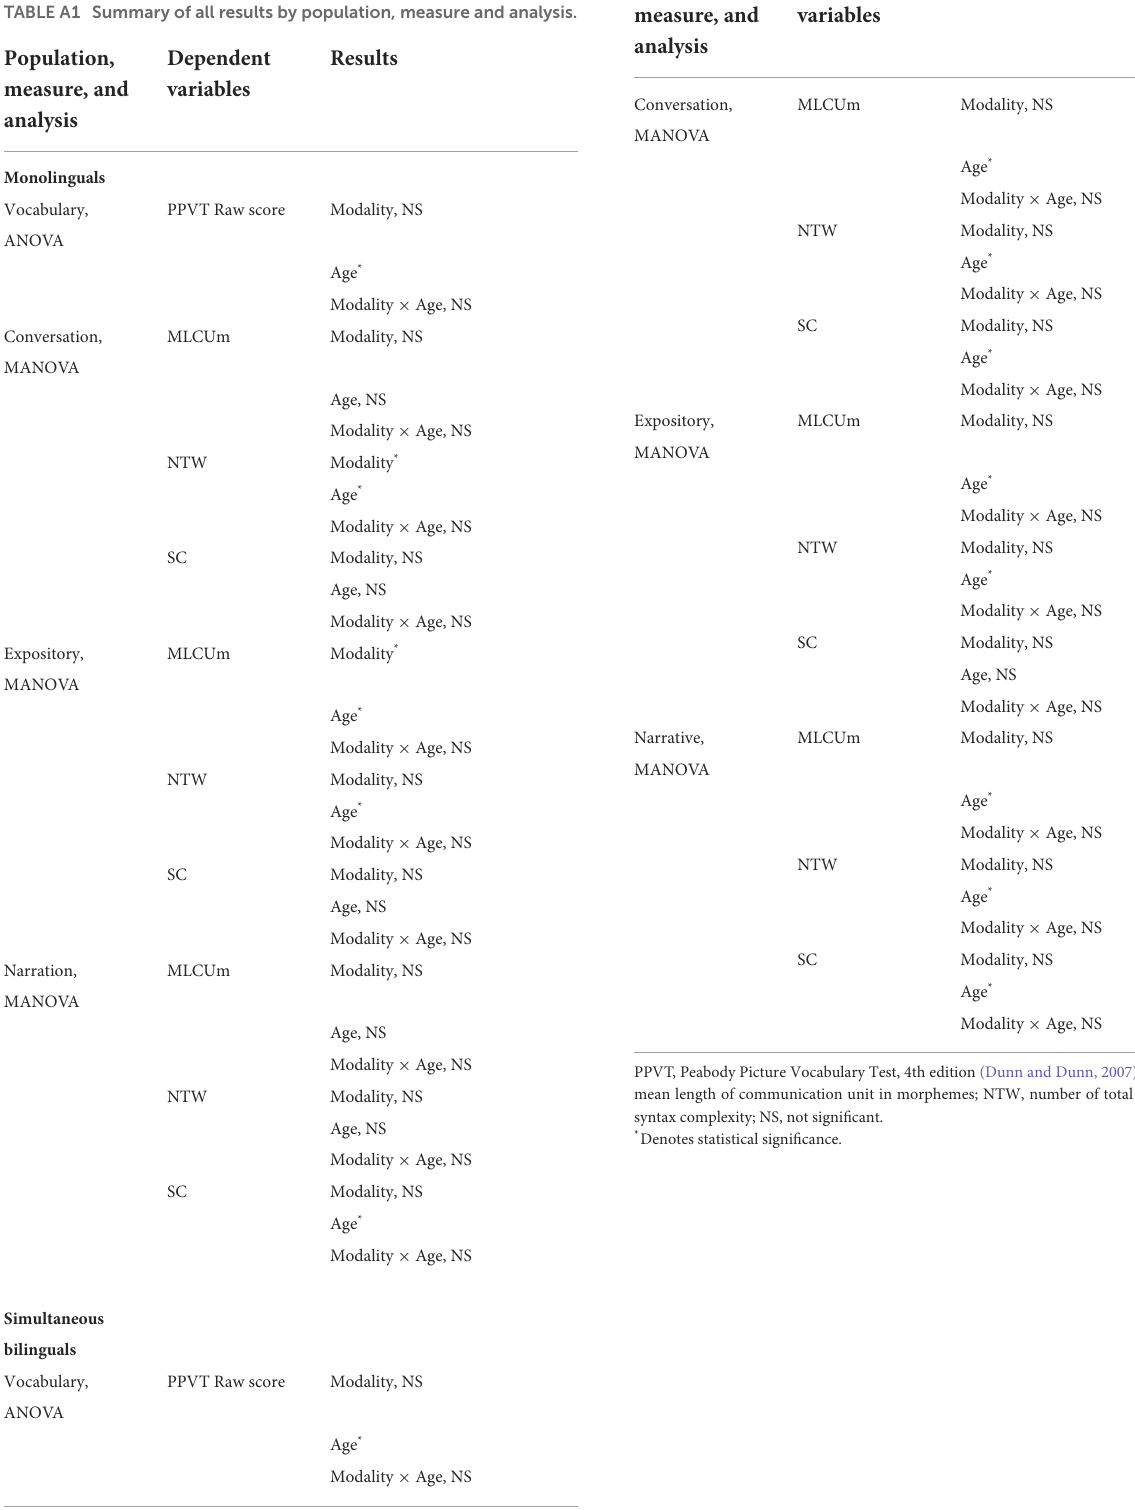
TABLE A1 Summary of all results by population, measure and